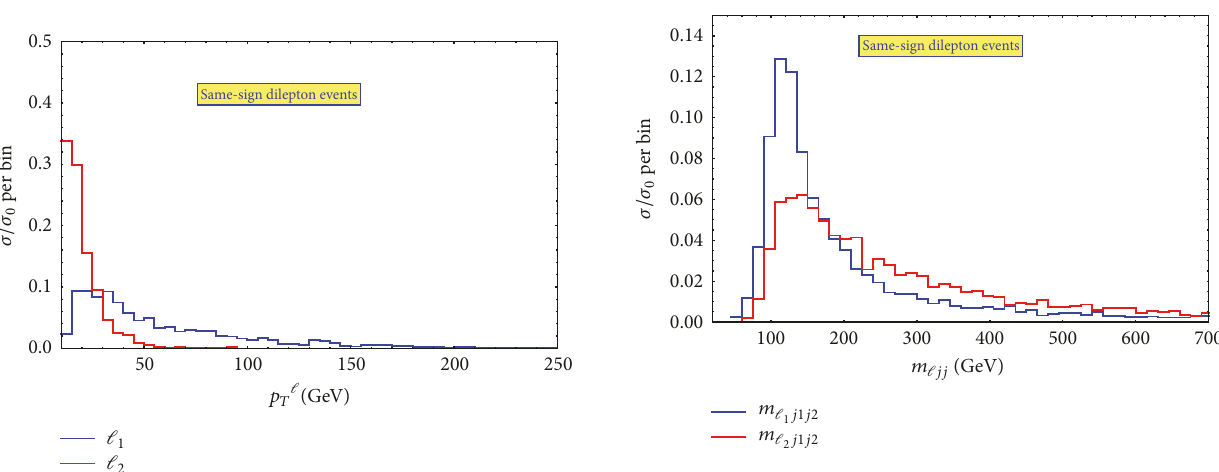
Figure 18: The invariant mass distributions of one lepton plus two- jet system (𝑚 𝑙𝑗𝑗 ) showing a peak around 𝑚 𝑁 ∼ 100 GeV (blue) from the same-sign dilepton plus di-jet